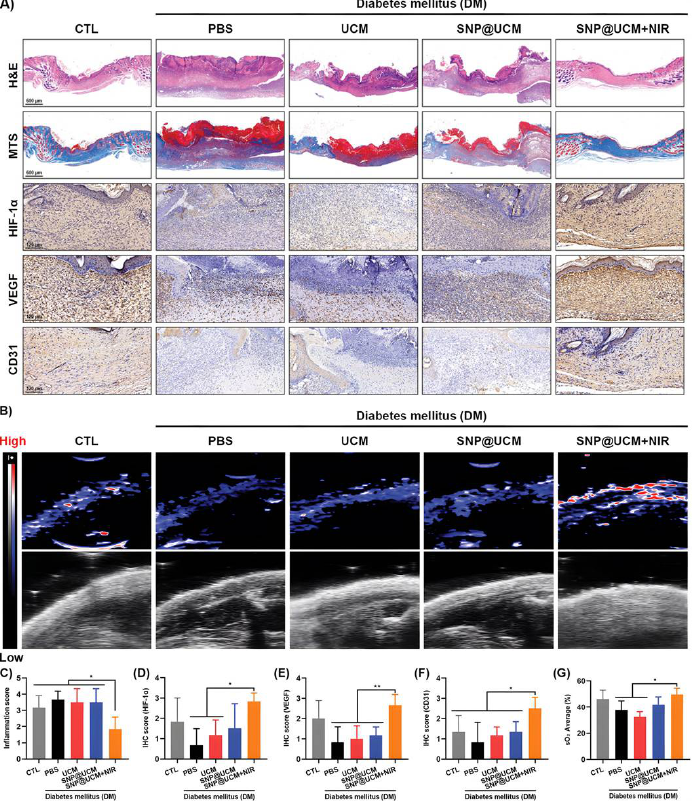
Figure 9. Accelerated in vivo angiogenesis and wound healing of infected diabetic ulcers in response to SNP@UCM treatment. ( A ) Hematoxylin and eosin (H&E) staining, Masson’s trichome staining, and immunohistochemistry (IHC) of wound tissues on day 14. ( B ) Ultrasound and photoacoustic images of wound tissues on day 14. ( C ) Inflammation score based on H&E staining. ( D – F ) Semi-quantitative analysis of IHC. ( G ) Semi-quantitative analysis of photoacoustic images. sO2: oxygen saturation. * p < 0.05, ** p < 0.01.Reproduced with permission [153]. Copyright 2021, Advanced materials